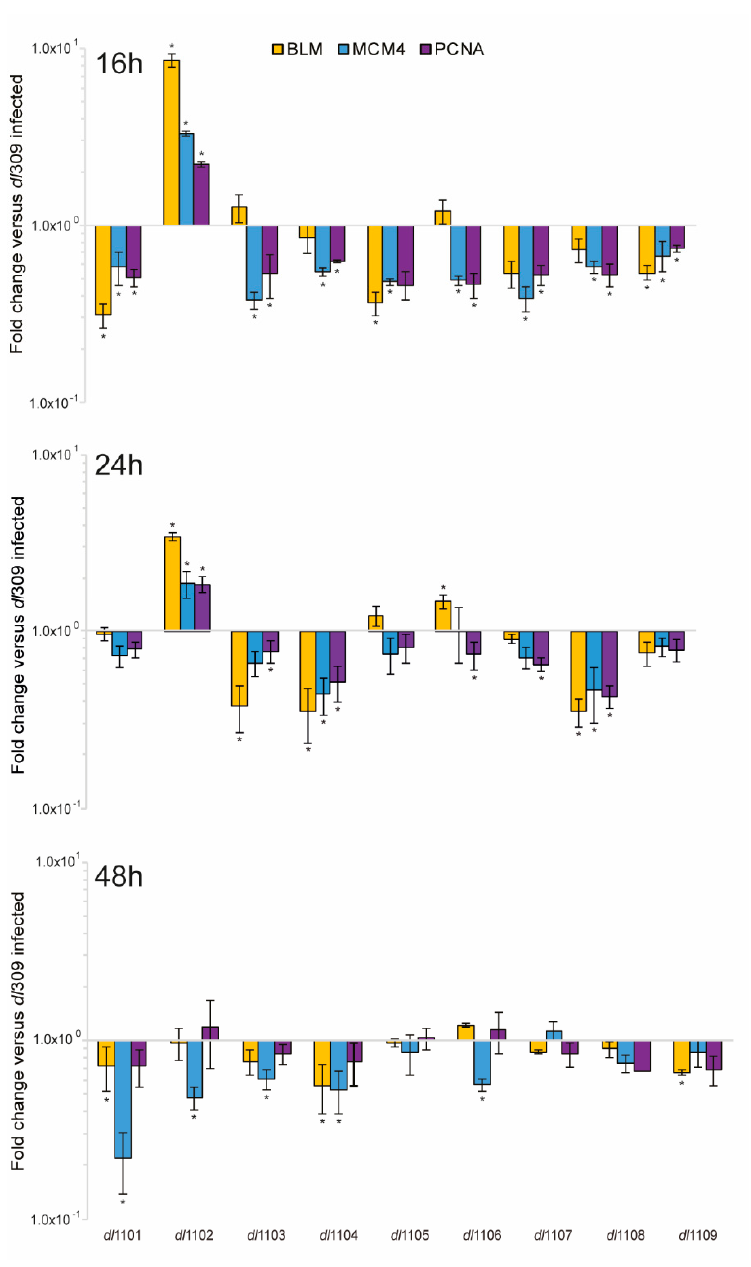
Figure 8. Expression of cellular S-phase regulated genes in WI-38 cells infected with E1A exon 1 HAdV5. WI-38 cells were grown until confluence at which point medium was replaced and cells were incubated for 72 h before infection with the indicated viruses at a MOI of 100. At the specified time-points total cellular RNA was extracted using NucleoZOL according to the manufacturer’s protocol followed by DNase I treatment to remove contaminating cellular and viral DNA. cDNA was synthesized using SuperScript VILO Master Mix and quantitative real-time PCR was performed on a BioRad CFX96 real-time thermocycler using SYBR Select Master Mix for CFX. Data were analyzed using the Pfaffl method and is presented as fold change versus dl 309. Error bars represent standard deviation of three biological replicates, asterisks represent statistically significant changes with a p- value of ≤ 0.0208.